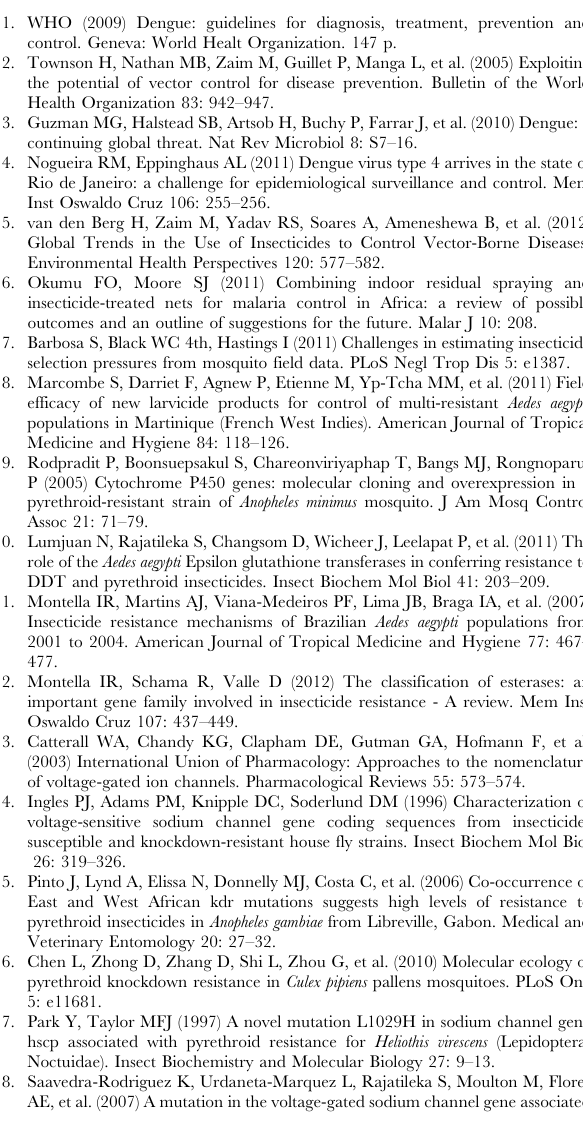
Table S2 Competition analysis, development time until adult. Number of individuals collected from each tray and observed genotypes. Table S3 Population cage experiments. Numbers of individuals genotyped from each cage throughout